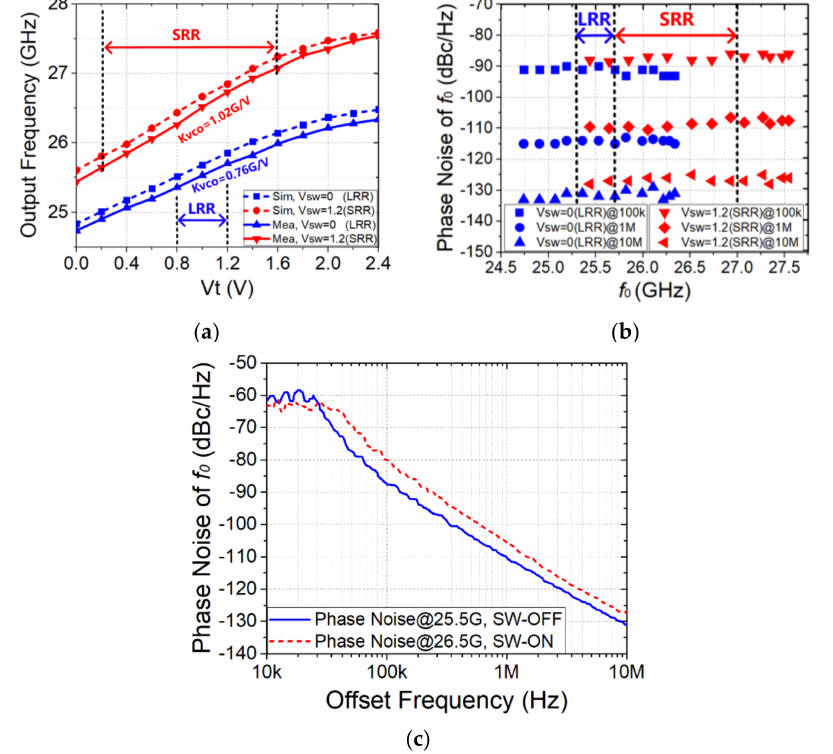
Figure 6. ( a ) Measured and simulated output frequency range for the K-band Colpitts VCO using Q-boosted switched inductor at switch ON / OFF states, and short-range radar (SRR) / long-range radar (LRR) frequency range if using a frequency tripler; ( b ) measured phase noise performance of the Q-boosted switched inductor VCO at switch OFF (for LRR) / ON (for SRR); ( c ) measured phase noise of the K-band FMCW frequency synthesizer at 25.5 GHz (switch-OFF, blue line), and at 26.5 GHz (switch-ON, red